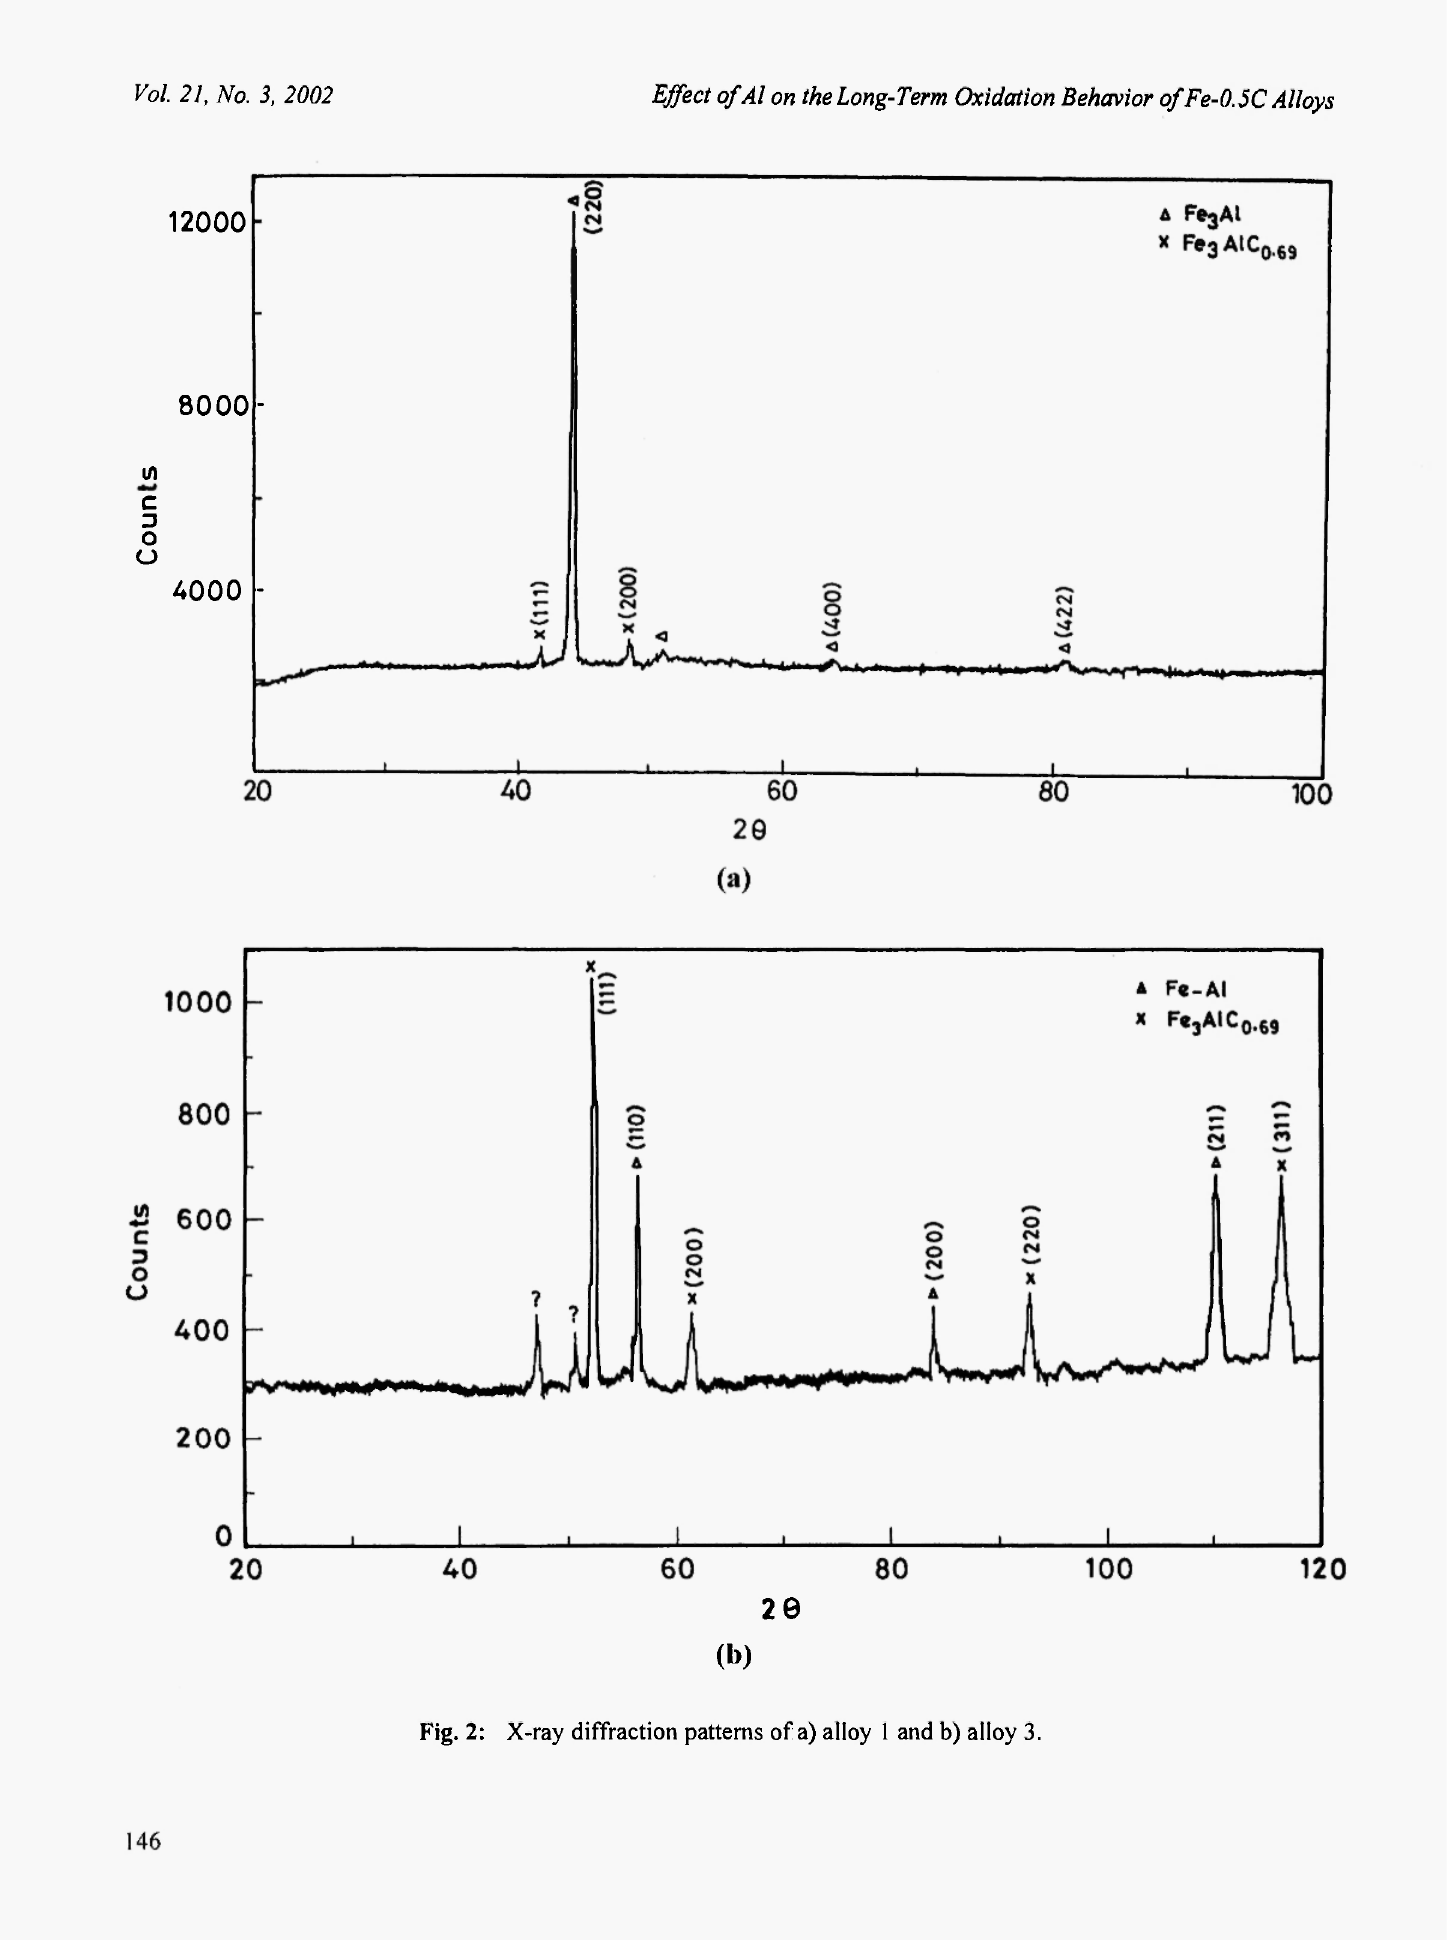
Fig. 2: X-ray diffraction patterns of a) alloy 1 and b) alloy